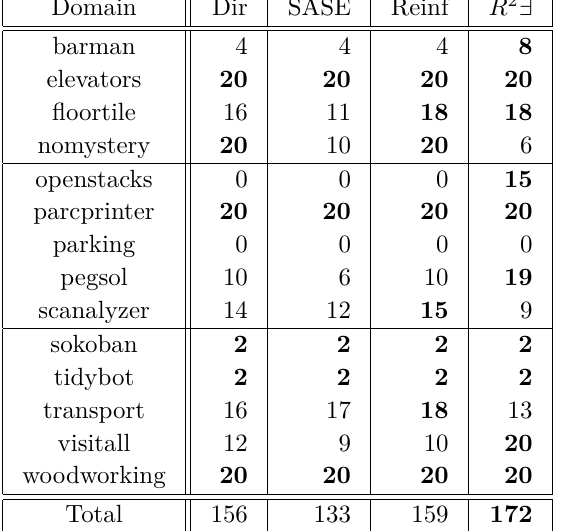
Table 1. The number of problems (out of 20) in each domain that the encodings solved within the time limit (30 minutes for SAT solving).